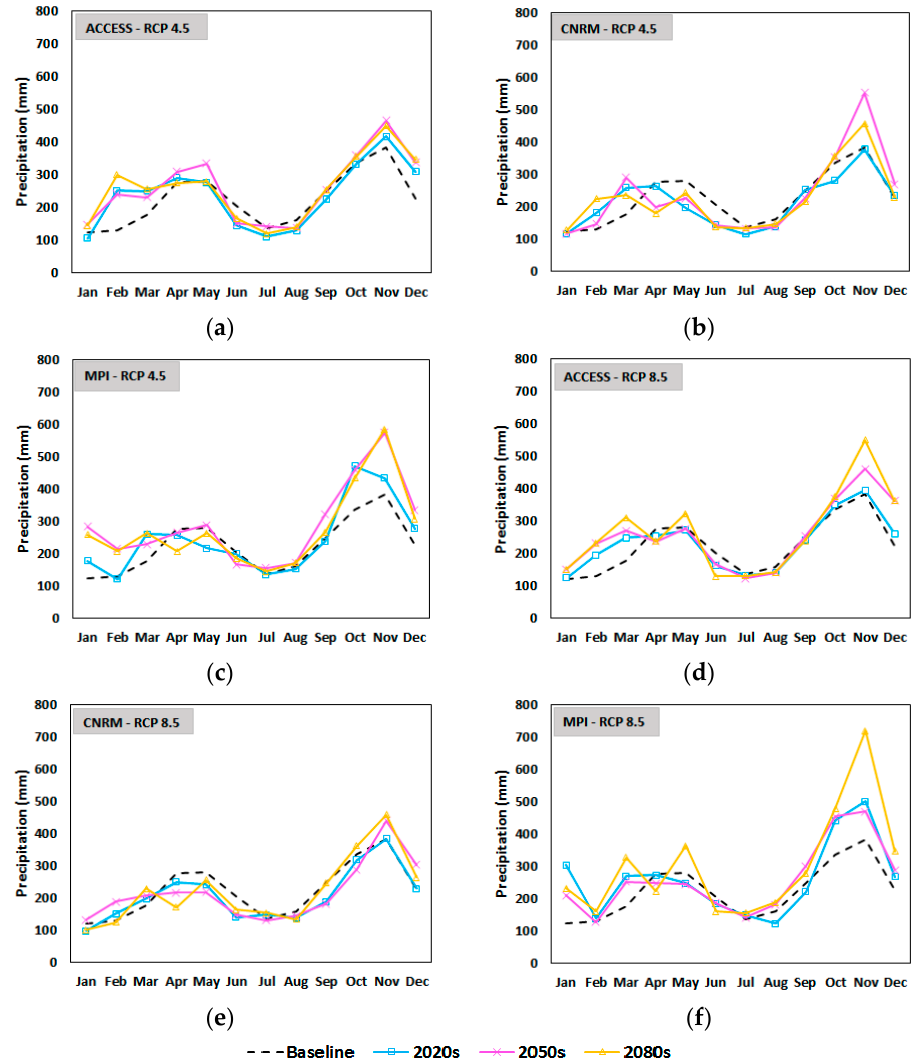
Figure 4. Monthly projected precipitation of NRB for 2020s, 2050s and 2080s under RCP4.5 and RCP8.5 scenarios compared with the baseline (1980–2020). ( a ) For ACCESS—RCP4.5, ( b ) for CNRM—RCP4.5, ( c ) for MPI—RCP4.5, ( d ) for ACCESS—RCP8.5, ( e ) for CNRM—RCP8.5, and ( f ) for